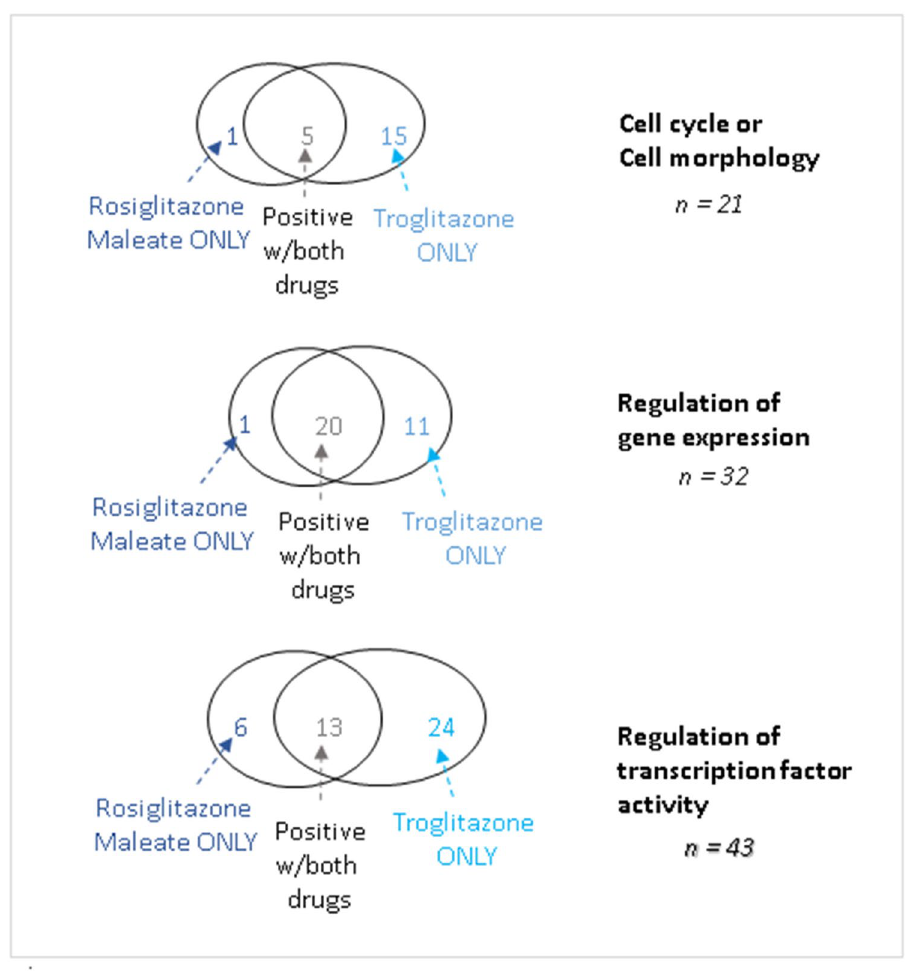
Figure 5. ToxCast database analysis: number of positive tests for troglitazone and rosiglitazone segmented by biological processes.